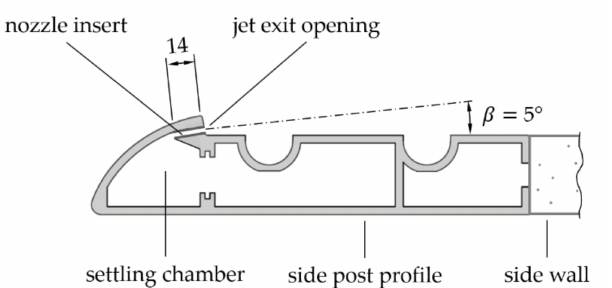
Figure 7. Side post profile with nozzle inserts to reduce the jet exit angle β and increase the guide ratio F —sectional